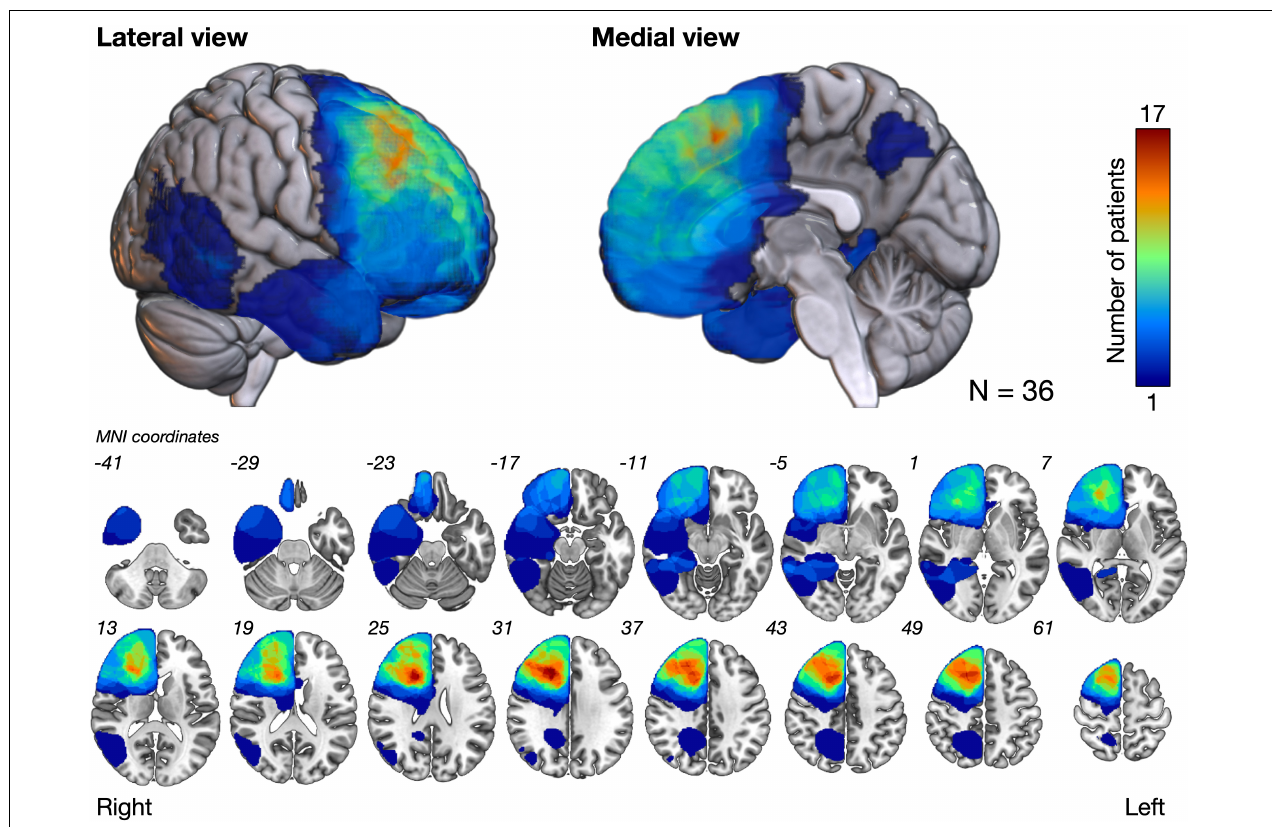
FIGURE 2 | The overlap map of resection cavities shows that the deep part of the medial prefrontal cortex had the greatest degree of overlap ( N = 17). MNI, Montreal neurological institute.